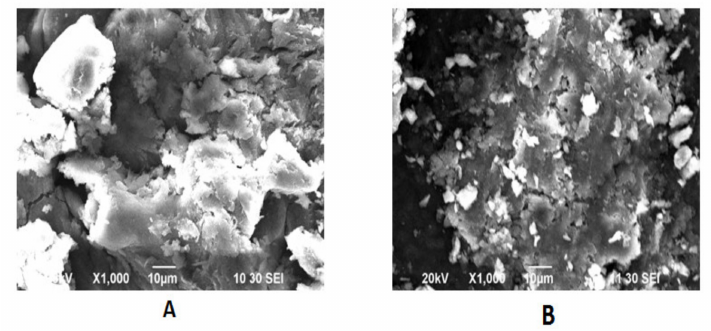
Figure 5. SEM images of composite SB-1 ( A ) at × 1000 magnification and composite SB-5 ( B ) at × 1000 magnification.